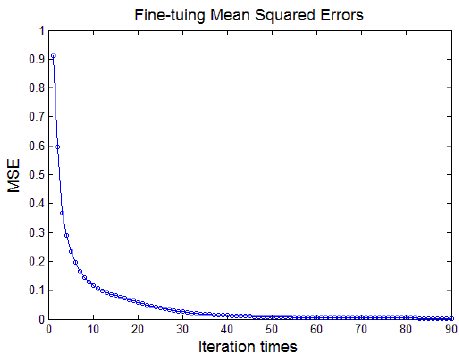
Figure 12. Relationship between the fine-tuning mean squared error (MSE) and iteration times.